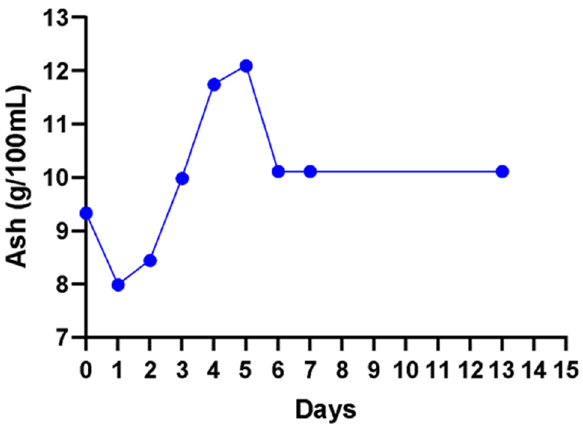
Figure 6. Change in ash content during fermentation of the wine.